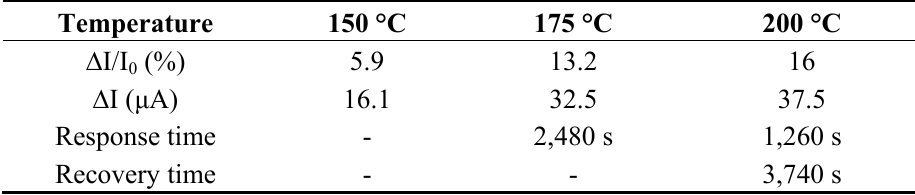
Table 2. Current variation ( ∆ I ), current variation ratio ( ∆ I/I for a bare In-polar InN sensor under exposure to 10 ppm acetone/air at various